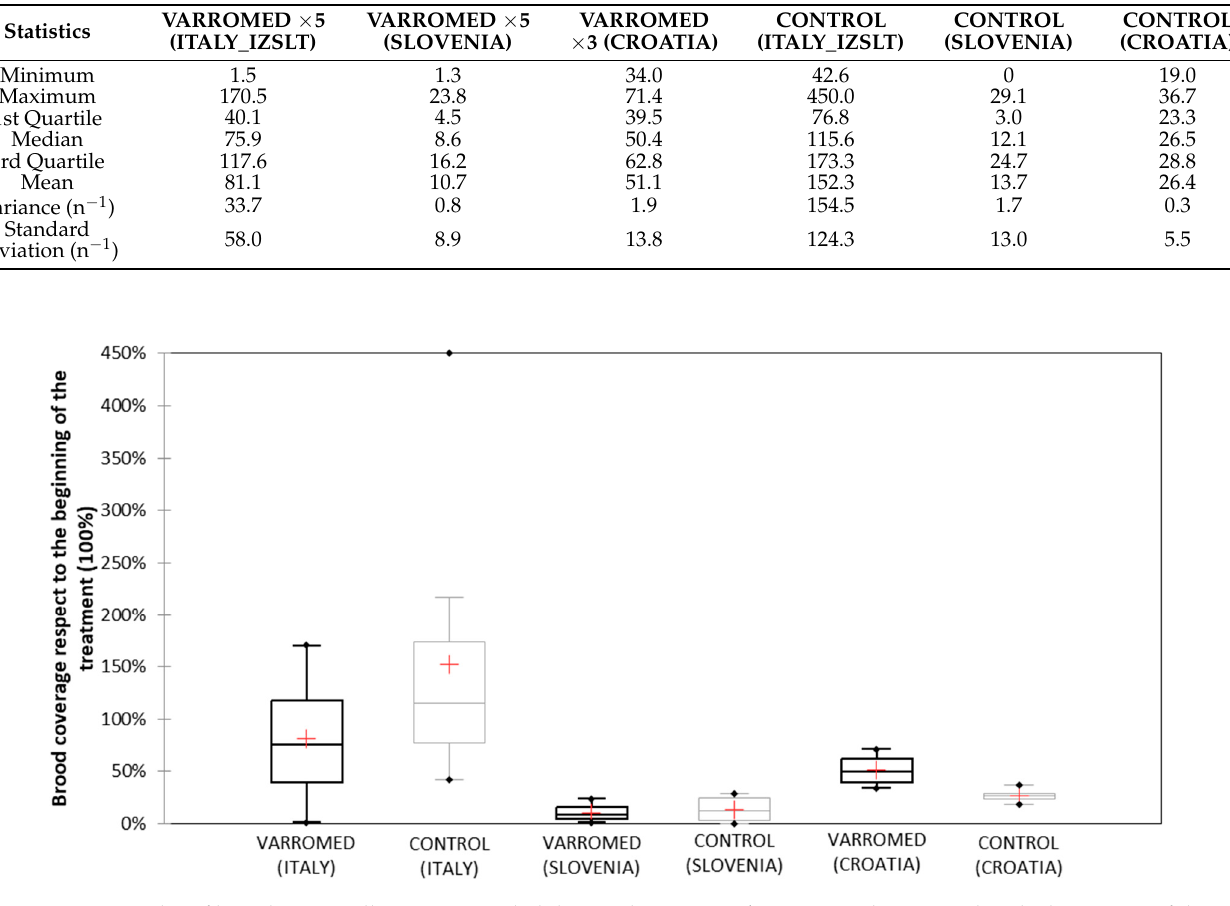
Table 5. Acaricide efficacy recorded during the summer/autumn trial in the apiaries and relative mite fall during the same period in the control group (%).